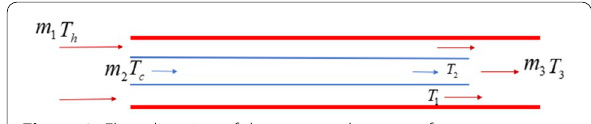
Figure 2 Flow direction of downstream heat